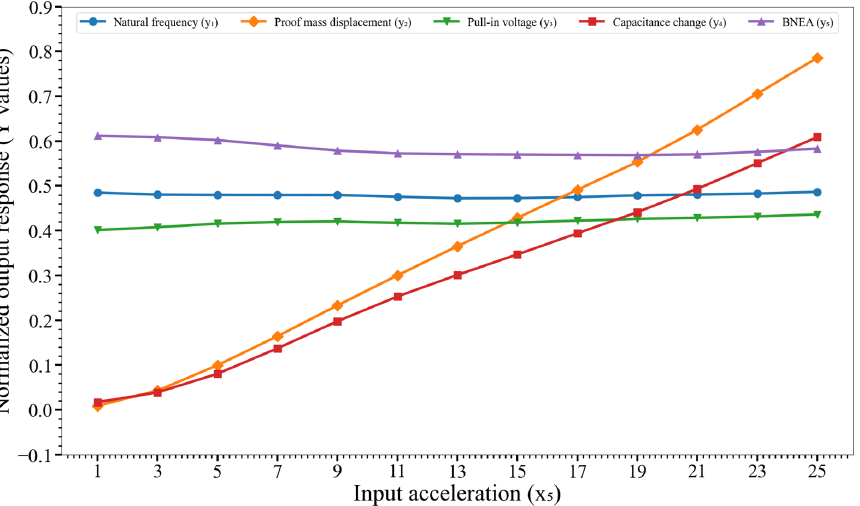
Figure 11. E ff ect of variation of the input acceleration (x 5 ) on the output responses y 1 , y 2 , …, y 5 . Key. Figure 11. Effect of variation of the input acceleration (x